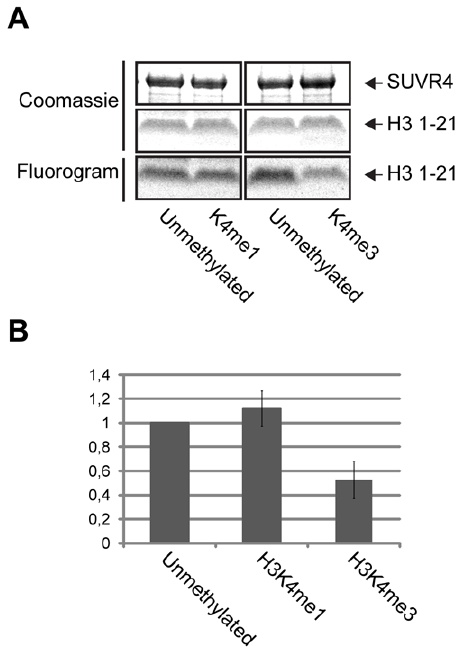
Figure 4. SUVR4 HKMTase activity is inhibited by H3K4me3. (A) HKMTase assay showing SUVR4 activity on peptides covering the first 1- 21 aa of histone H3, that are unmodified, monomethylated or trimethylated on K4. (B) Quantification of band intensity from fluorogram in A, relative to the reaction with unmodified H3 1-21 peptide. The bars represent the average of three independent HKMTase assays. doi:10.1371/journal.pgen.1001325.g004 PLoS Genetics |